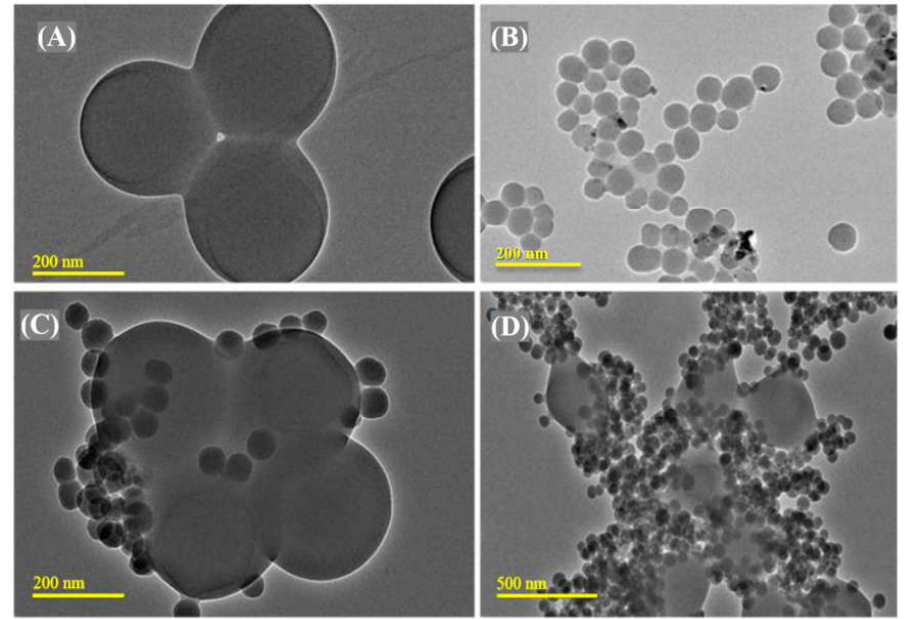
Figure 5. TEM analysis of ( A ) PMMA-NR, ( B ) silica and ( C , D ) PMMA-NR-Si-TAM at 200 nm and 500 nm.